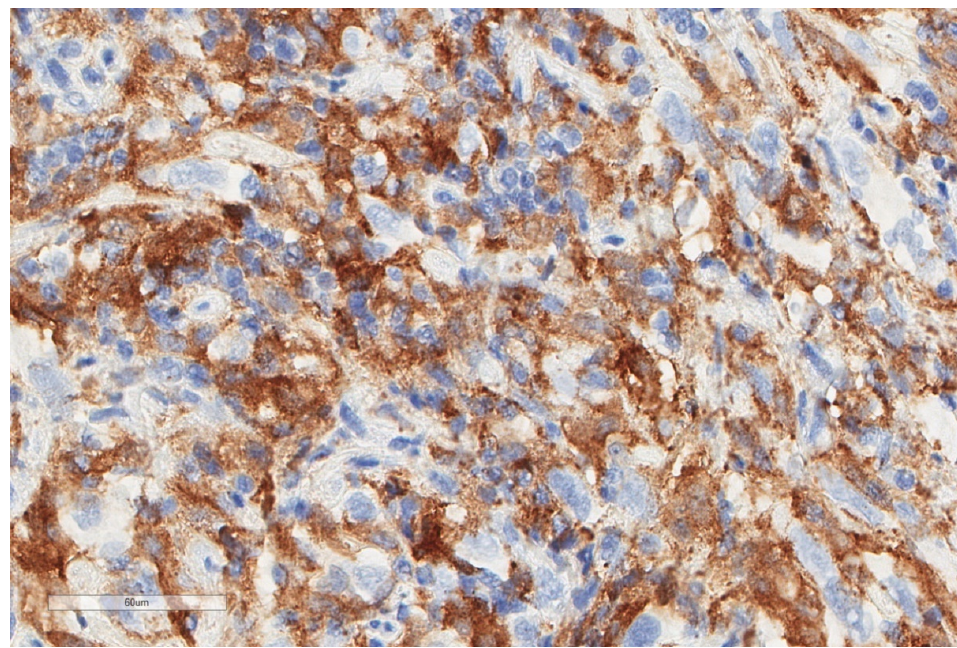
Figure 2. The same focus of epithelioid mesothelioma as that shown in Figure 1, stained for CD163, revealing numerous macrophages (X400).